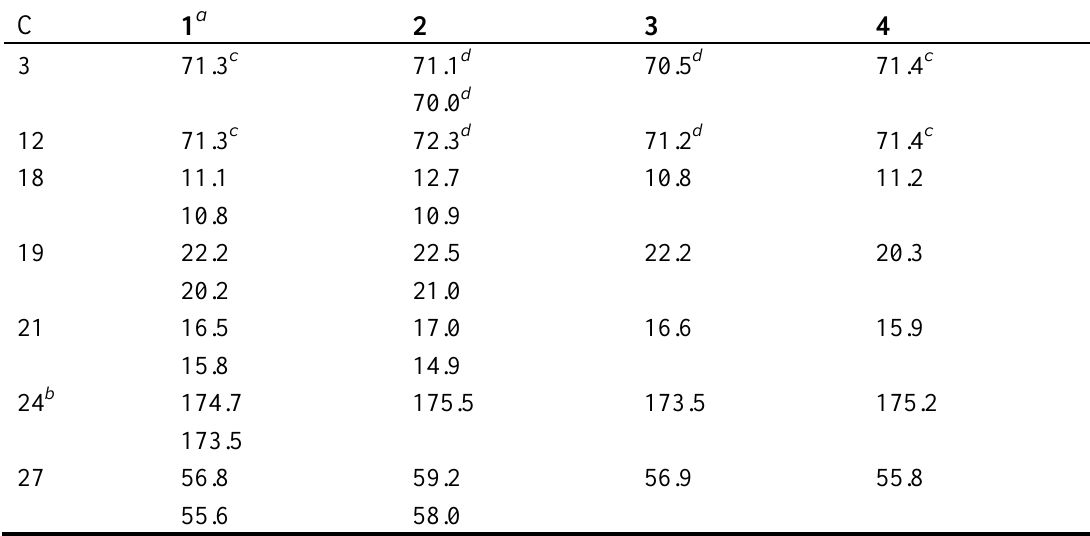
Table 1. Selected chemical shifts in solid state 13 C CP/MAS NMR of 1 - 4 .